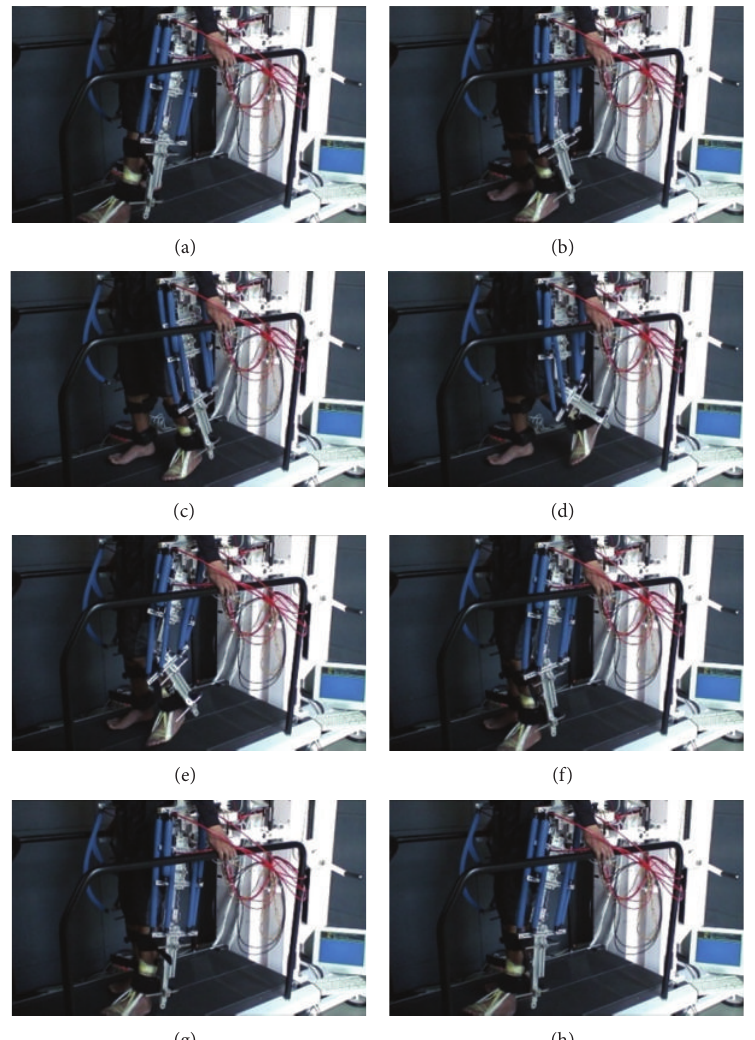
Figure 5: Control of the leg orthosis with a subject